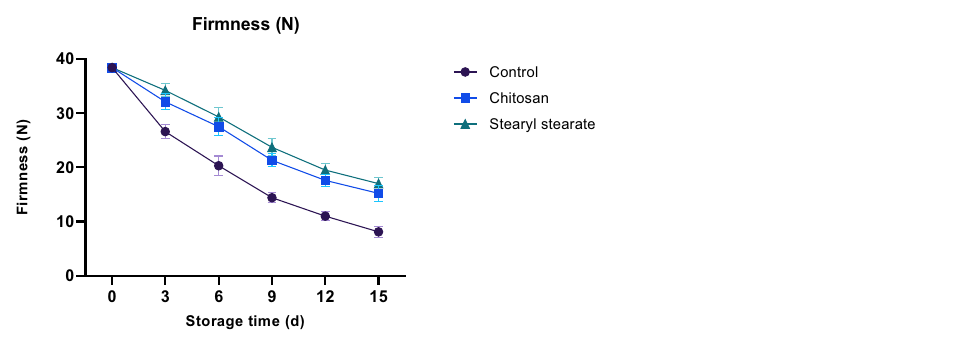
Figure 4. Firmness of stored